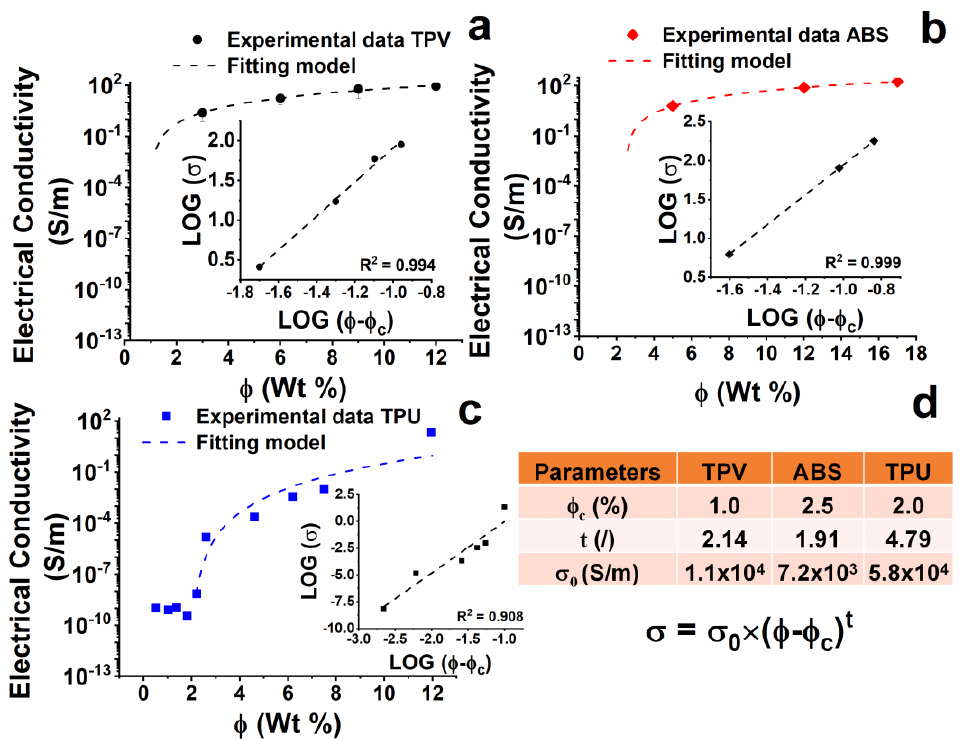
Figure 8. Electrical conductivity of produced nano-composites and results of percolative theory applied to the experimental dataset of the samples: ( a ) TPV(x); ( b ) ABS(x); ( c )TPU(x); ( d ) Fitting parameters of the percolative theory.